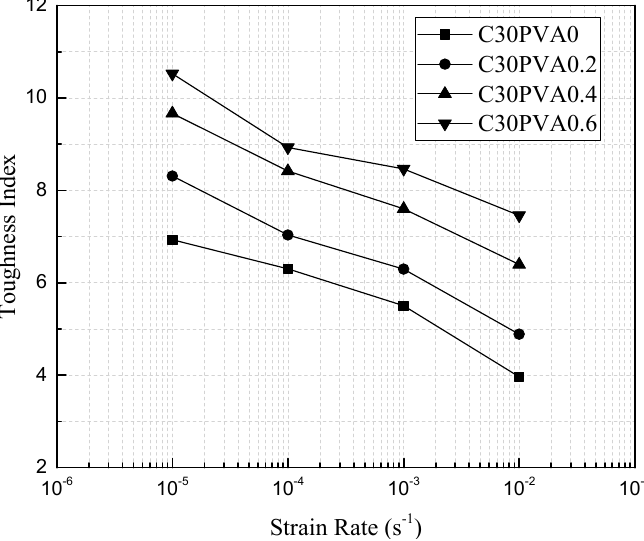
Appl. Sci. 2018 , 8 , x FOR PEER REVIEW Figure 18. Toughness index of FRC (C30). Figure 18. Toughness index of FRC (C30).